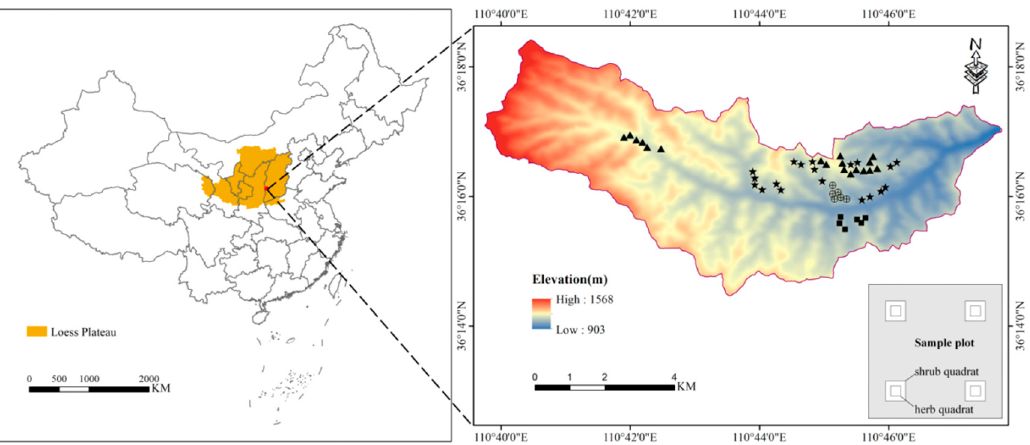
Figure 1. Location of the study area and sampling plots ( ★ , R. pseudoacacia forest; ▲ , P. tabuliformis forest; ⯀ , shrubland; and ⊕ , abandoned farmland). The figure in the lower right corner shows the settings of the shrub and herb quadrat in the sample plot.